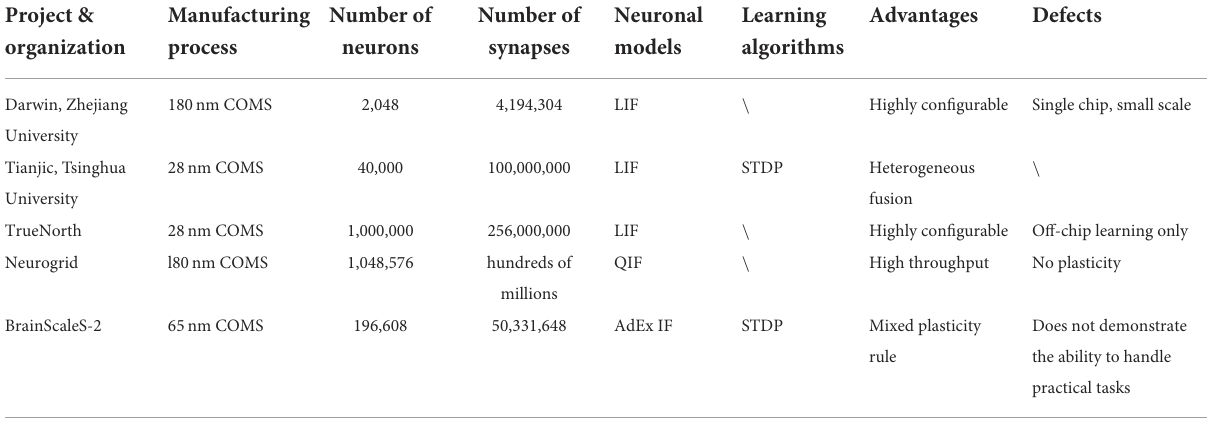
TABLE 2 Brain-like chip summarization and